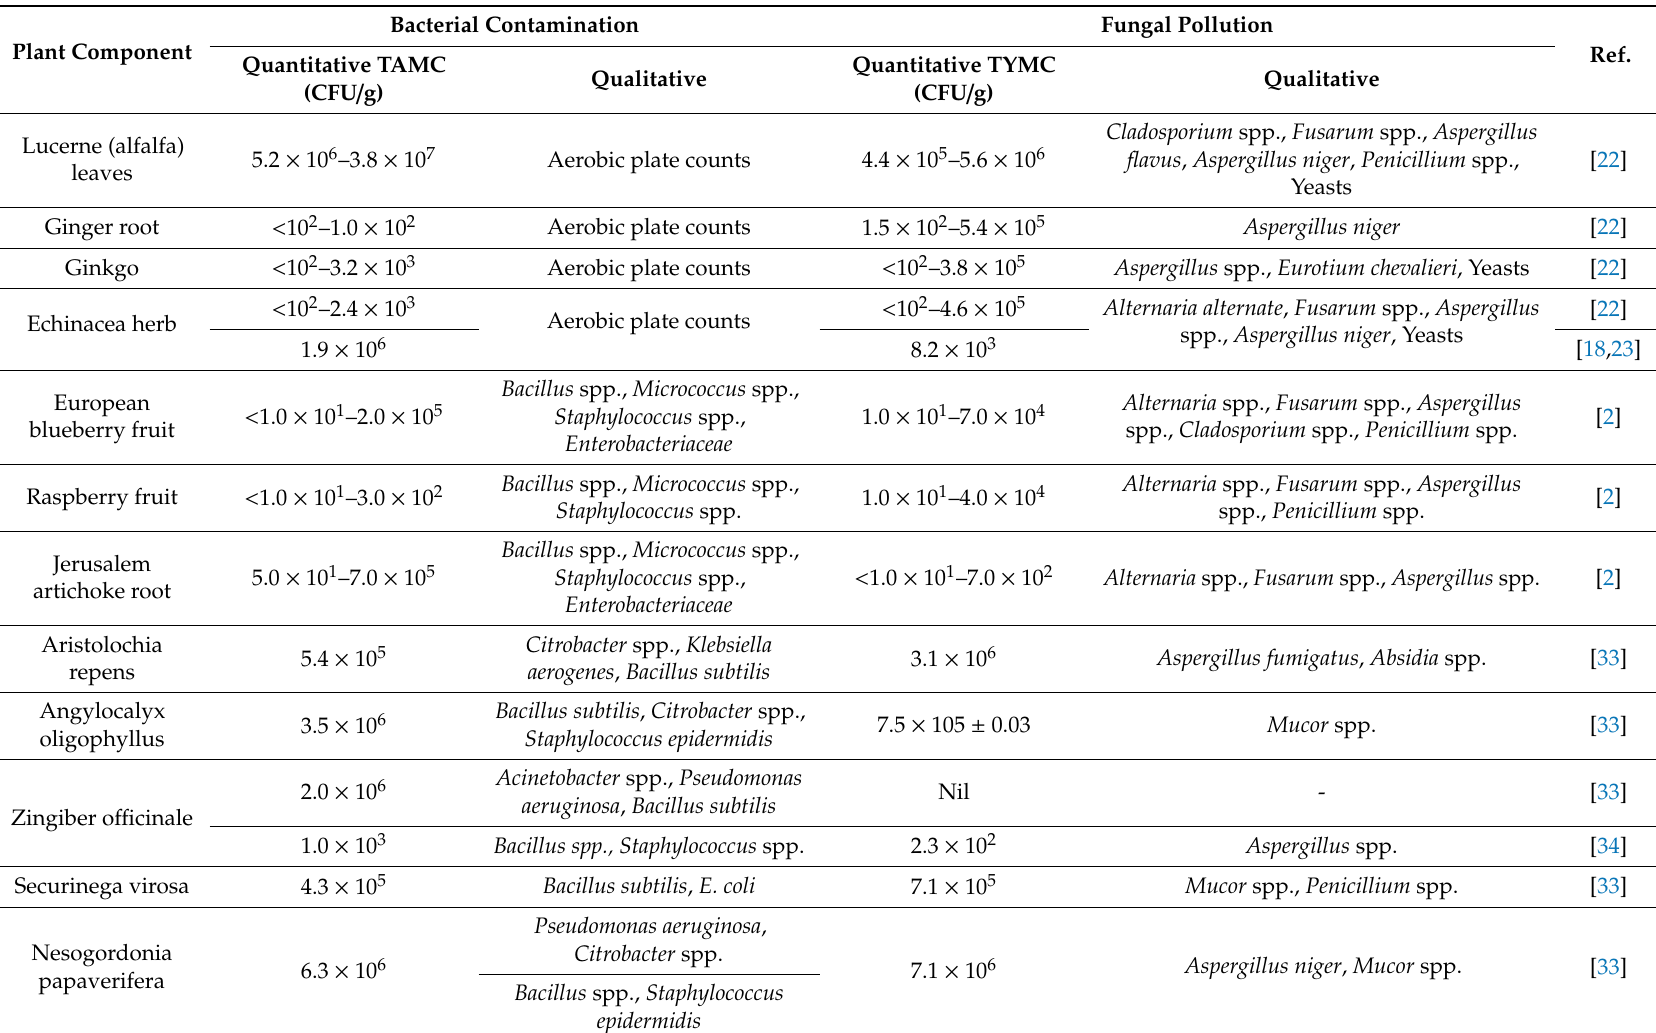
Table 1. Qualitative and quantitative microbiological contamination of dietary